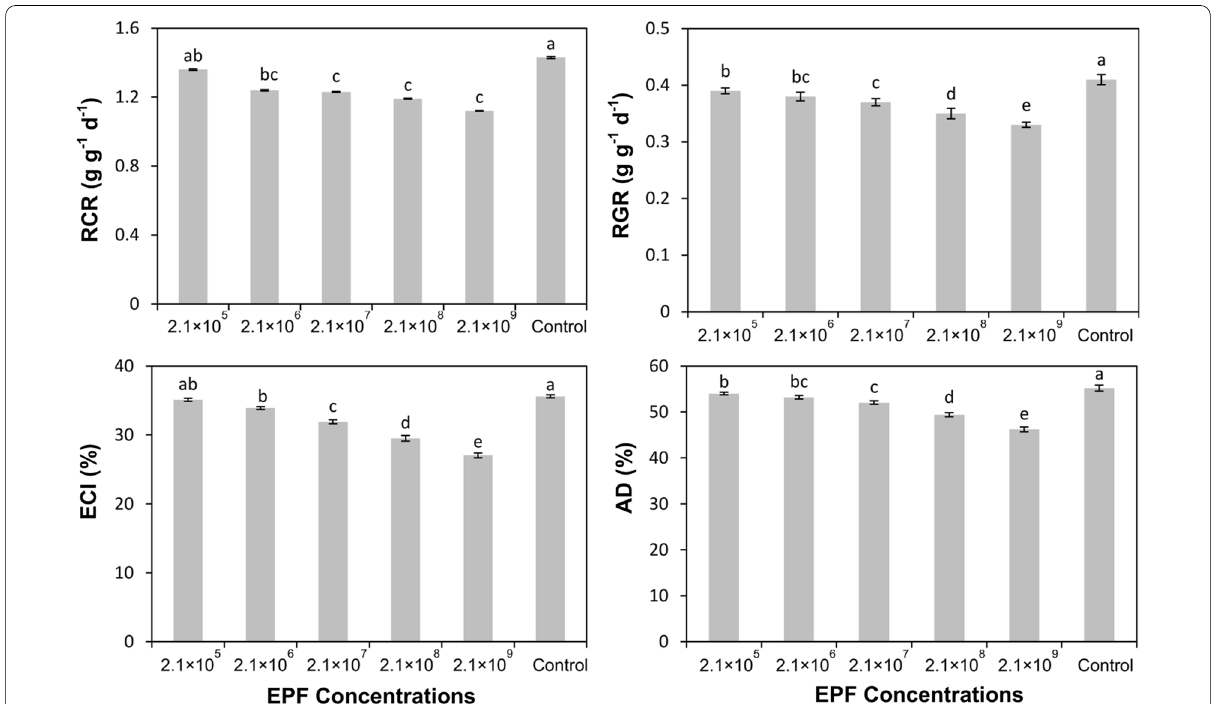
Fig. 1 Effect of various conidial concentration of Metarhizium anisopliae on nutritional physiology (means RCR relative consumption rate, RGR = means sharing similar letters are not statistically significant at P >